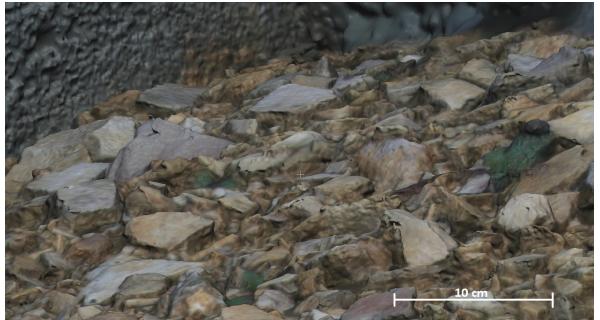
Figure 2. Detail of the surface model with 57 million points. The rough surface of the metal plot border results from its flat surface which impedes feature detection for SfM.